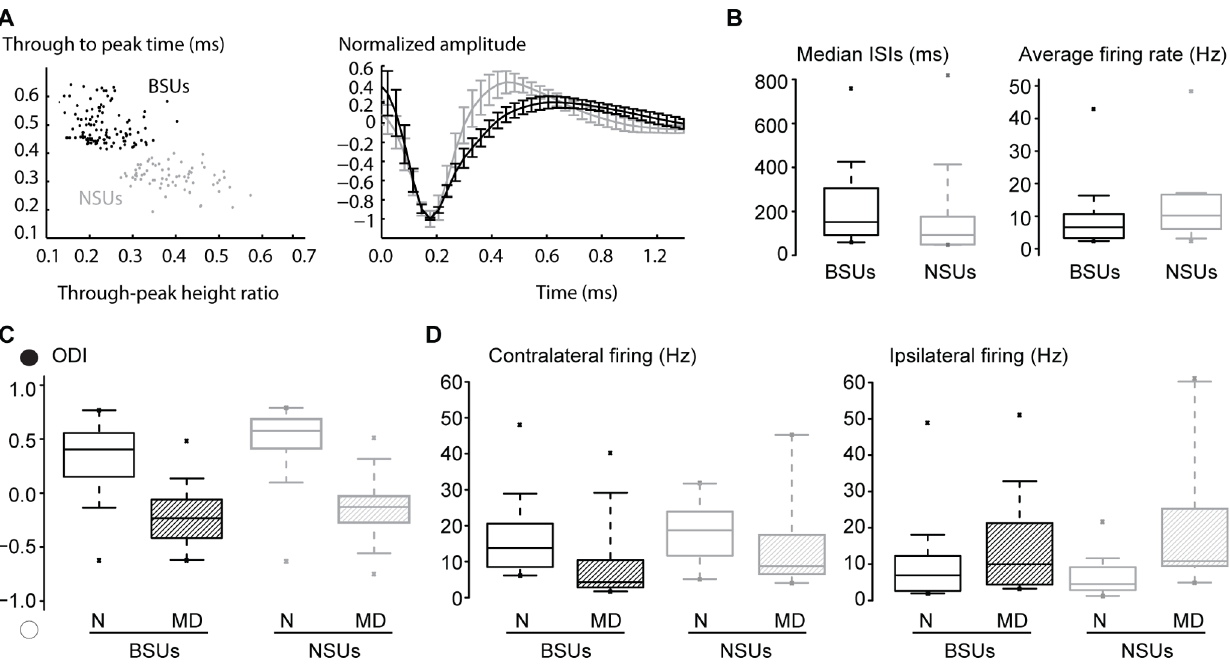
Figure 7. MD caused a comparable ocular dominance plasticity in extracellularly isolated, putative excitatory and inhibitory units. A. Outcome of the sorting of BSUs and NSUs from multiunit extracellular recordings in terms of AP waveform parameters. Right: average 6 s.e.m. AP shape of isolated BSUs (black) and NSUs (gray). Note the shorter AP duration and deeper afterhyperpolarization for NSUs. Left: plot showing the through-to-peak time vs through-peak height ratio of single isolated units. Note the clusters of the BSUs (black dots) and NSUs (gray dots). B. Spontaneous firing rates of NSUs were higher compared to BSUs. Median ISIs are plotted on the left, averaged firing rates on the right (Mann-Whitney Rank Sum tests, p , 0.01). C. MD caused a significant drop of ODIs for both BSUs (black) and NSUs (gray) [t-tests, p , 0.001]. D. Both depression of responses to the contralateral eye (left, closed in MD rats) responses and potentiation of responses to the ipsilateral eye (right, open in MD rats) were significant for both BSUs (black) and NSUs (gray) – Mann-Whitney Rank Sum tests, p ,